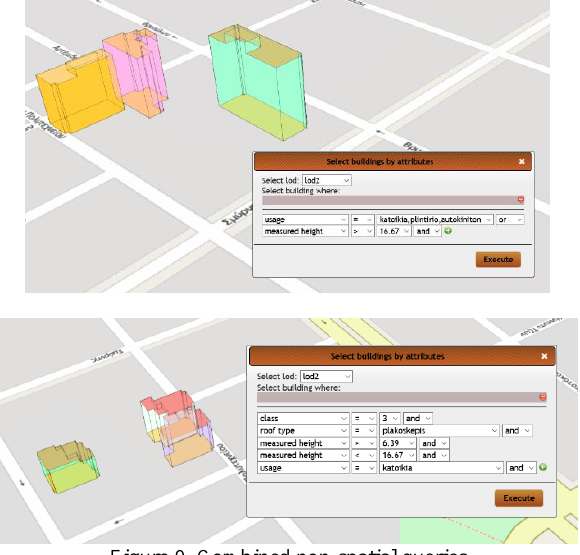
Figure 9. Combined non-spatial queries